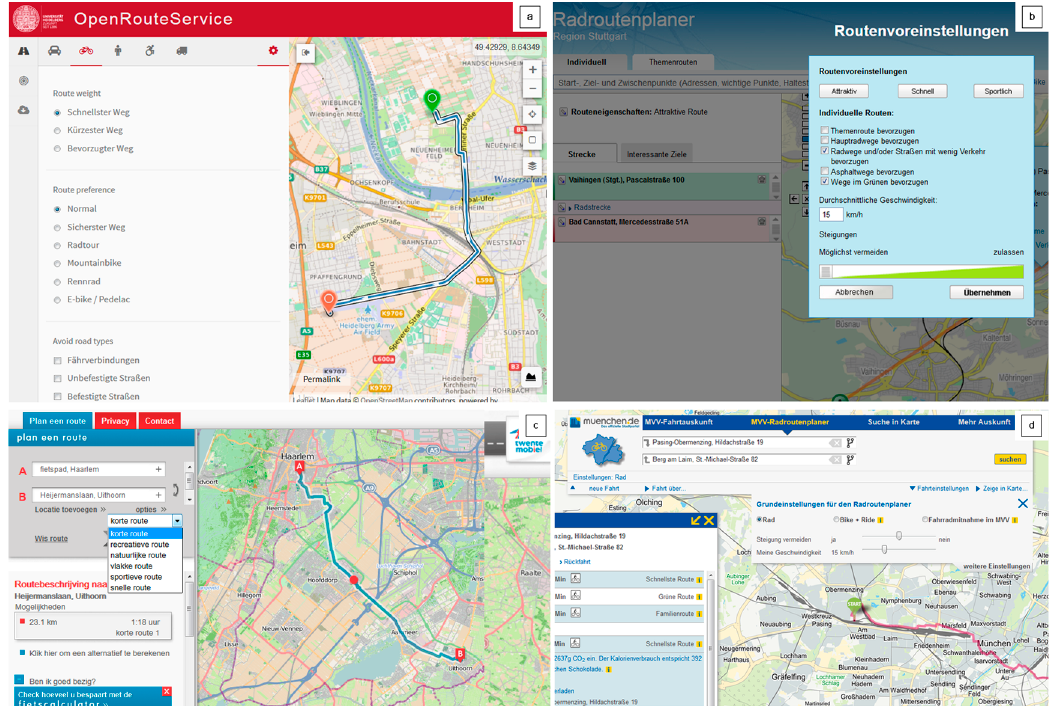
Figure 3. Graphical user interface design for the selection of routing criteria. ( a ) OpenRouteService with radio buttons; ( b ) Radroutenplaner Region Stuttgart with check boxes; ( c ) Fietsrouteplanner with combo boxes; ( d ) MVV Radroutenplaner with slider bars.